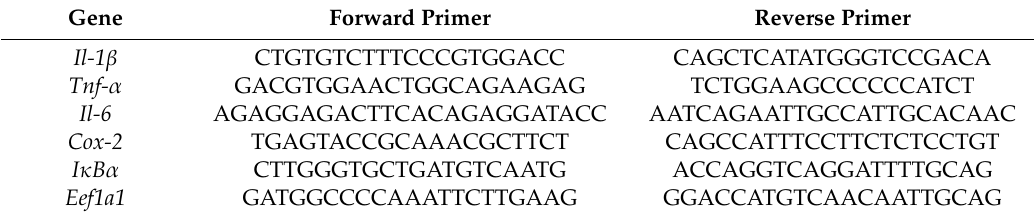
Table 1. Nucleotide sequences of primers used for quantitative